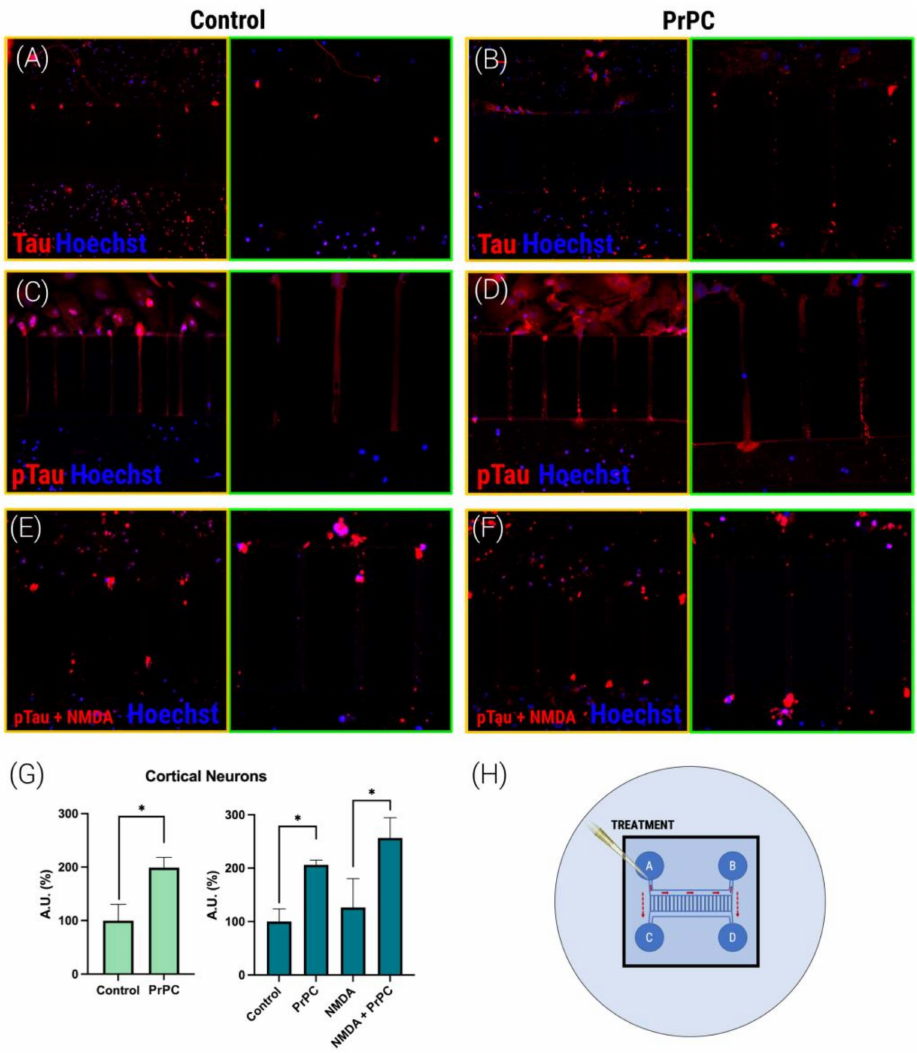
Figure 3. Detection of Tau and pTau axonal transport in mice cortical primary neurons. Mice cortical neurons were grown in the microfluidic device ( A – F ). On DIV 10 and once the axons fully crossed the microgrooves (150 µ m distance), Tau (1 µ M) or pTau (1 µ M) proteins were added into